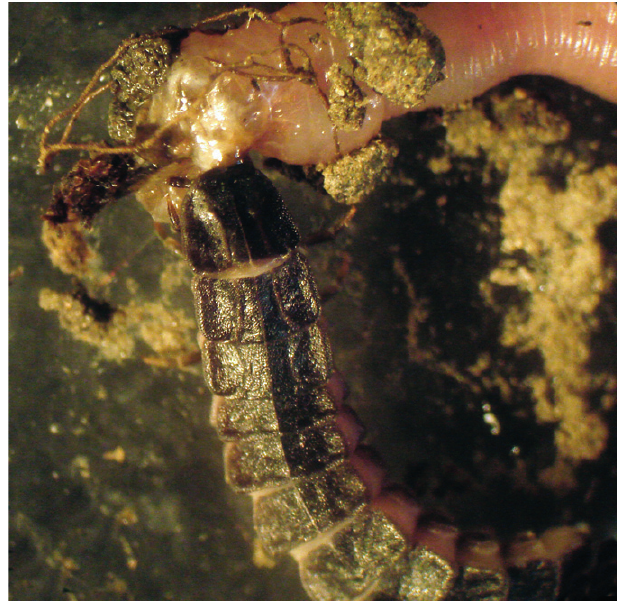
Figure 6. A Phosphaenus hemipterus larvae feeding on an earthworm ( Lumbricus terrestris ). While feeding, the tarsal claws of the legs anchor the larva to the body of the earthworm and the extended antennae move over the surface of the earthworm’s body. Photo credit: Christopher